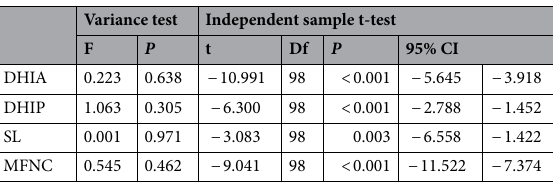
Table 4. Comparison between the case group and the control group. CI Confidence interval.